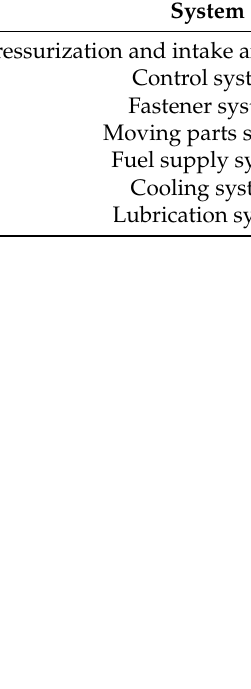
Table 8. The expert evaluation results of each failure mode.